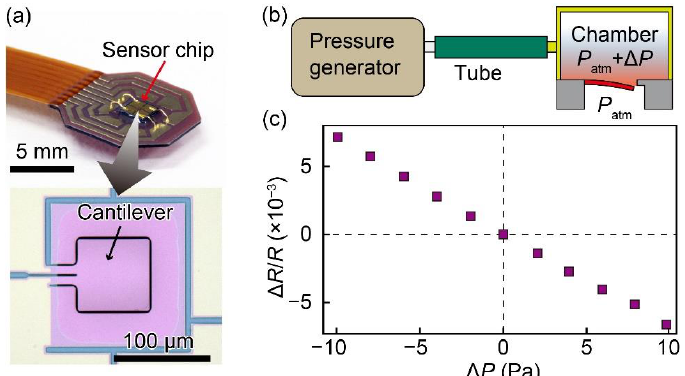
Figure 2. ( a ) Photographs of the fabricated sensor chip attached on a flexible substrate and the cantilever. ( b,c ) Conceptual sketch of the calibration setup and the calibration result.